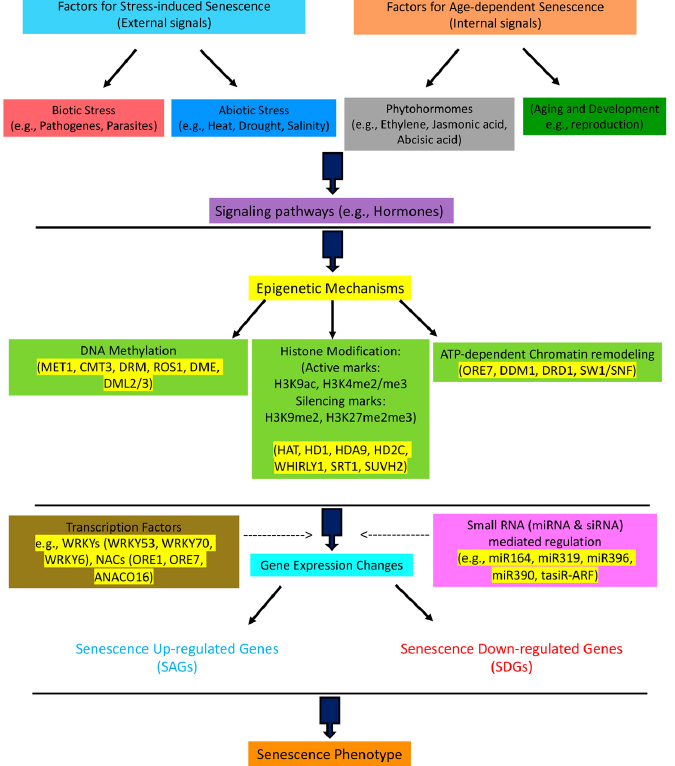
Figure 1. Multilayer regulatory network of plant senescence. The senescence program is influenced by external (stress-induced) and internal (developmental) signals. It is known that downstream of signaling pathways, such as in phytohormone activity, and upstream of transcription factors, such as WRKYs and NACs that regulate the expression of senescence genes, there are higher-level epigenetic mechanisms that control the process of senescence. The epigenetic mechanisms regulate the expression of transcription factors and other senescence-related genes via DNA methylation, histone methylation/acetylation, chromatin remodeling, and the interactions of small RNAs, such as miRNA and siRNA, with senescence-related genes. The name for the main factors in every step is